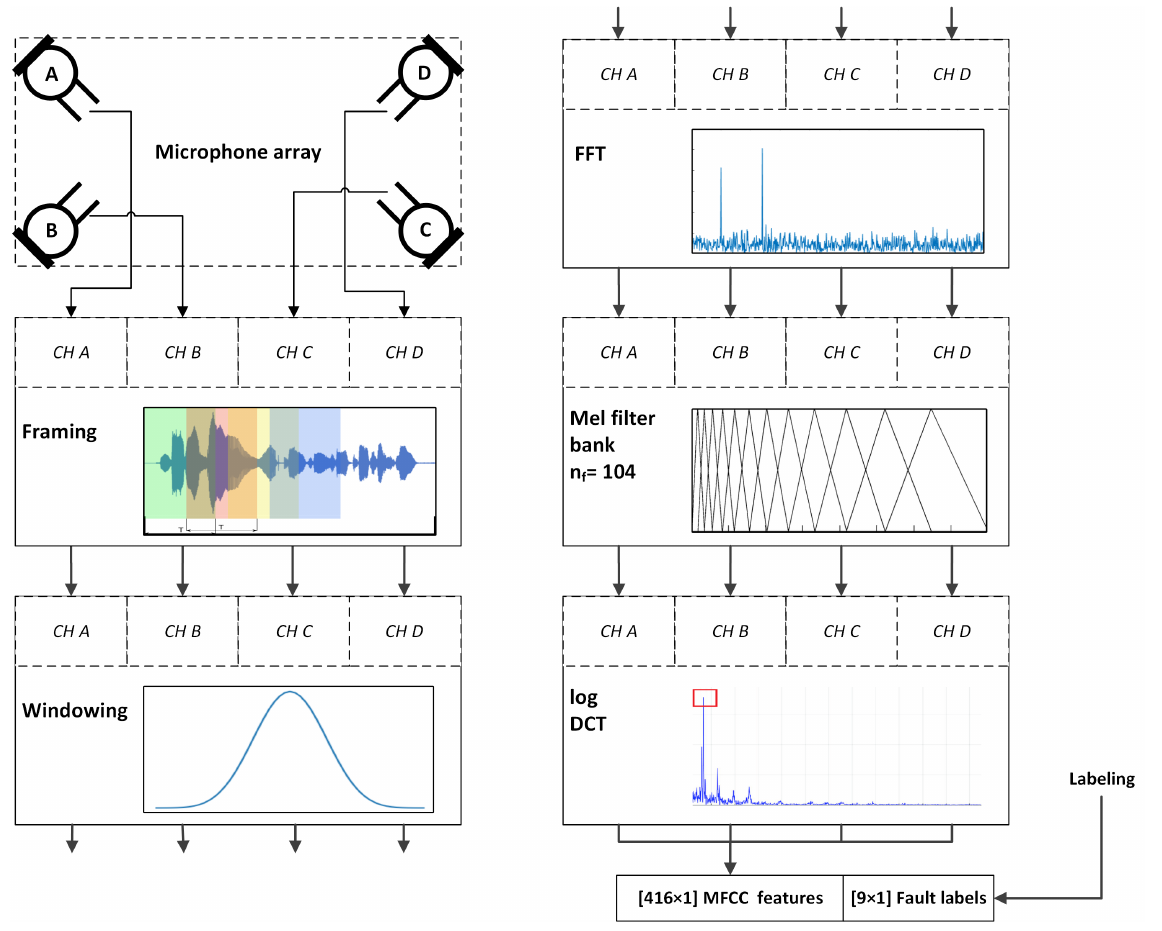
Figure 6. Summary of the pretraining signal processing steps.